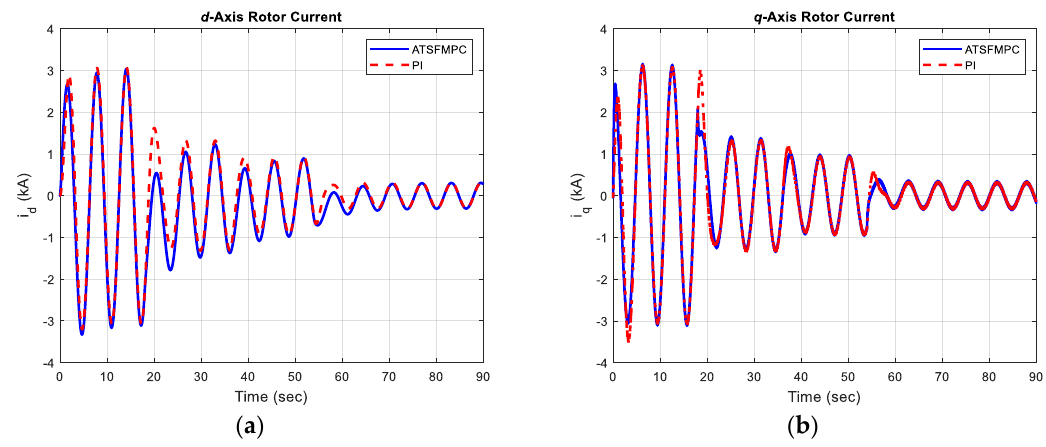
Figure 9. Response of d -axis and q -axis rotor currents for PI and ATSFMPC for Pentland Firth tidal current.